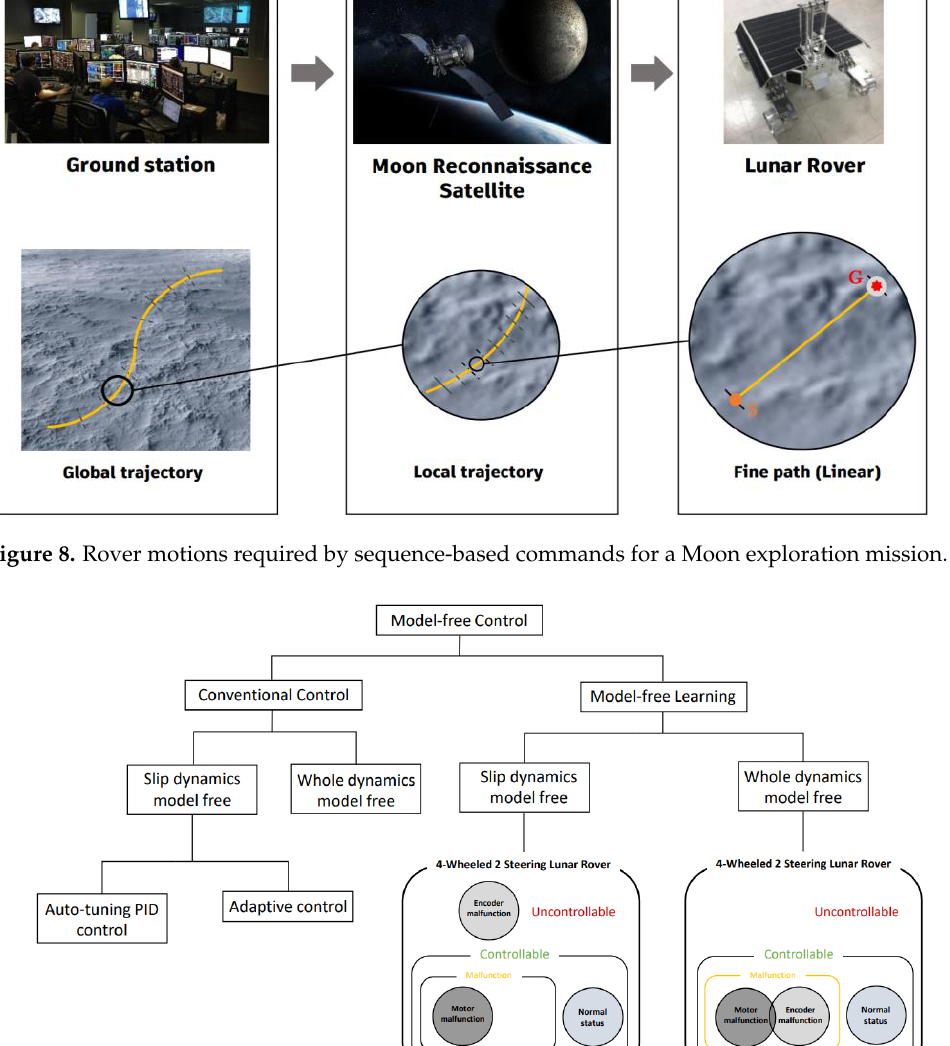
Figure 10. Classification of reinforcement learning approaches. Meanwhile, among off-policy learning methods, the policy-search approach is more advantageous than the value-search approach, in that fewer calculations are required to